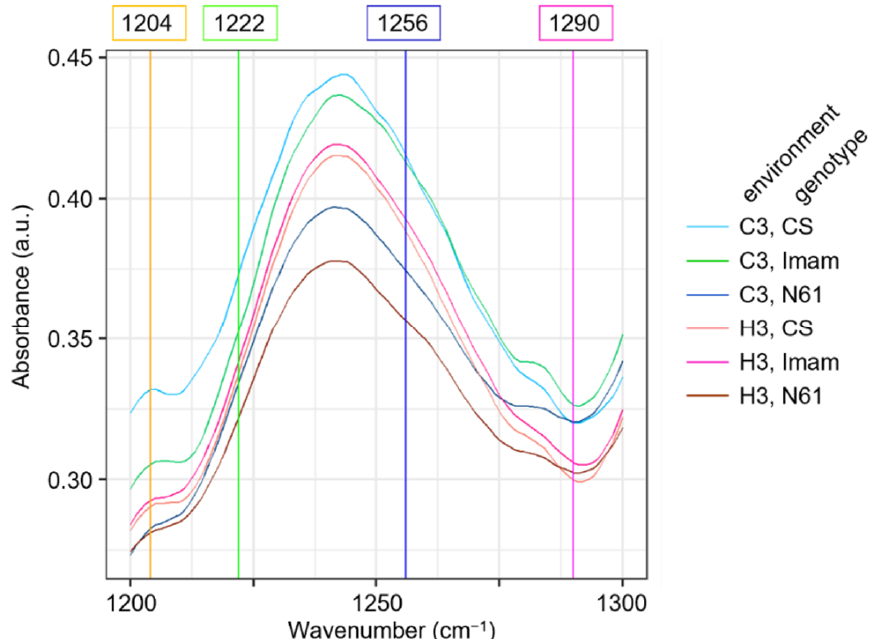
Figure 7. Magnified view of averaged FTIR spectra in the wavenumber range from 1200 to 1300 cm − 1 for strong discriminatory variable wavenumbers detected in LDA. Averaged spectra for six wheat genotypes × environment combinations are shown, according to the legend depicted on the right. Col- ored vertical straight lines and their numbers on top of the panel denote characteristic wavenumbers detected in LDA as strong discriminatory variables.